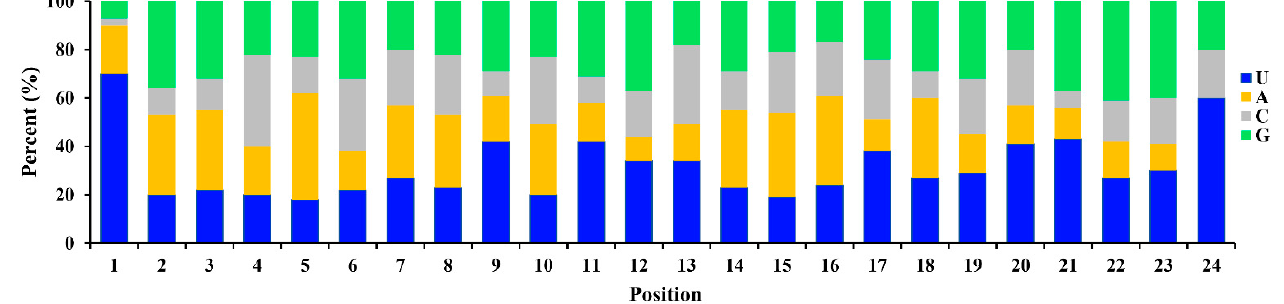
Figure 3. Nucleotide bias at each position in known mature miRNAs of C. farreri . Number of x -axis represents each position of miRNA.